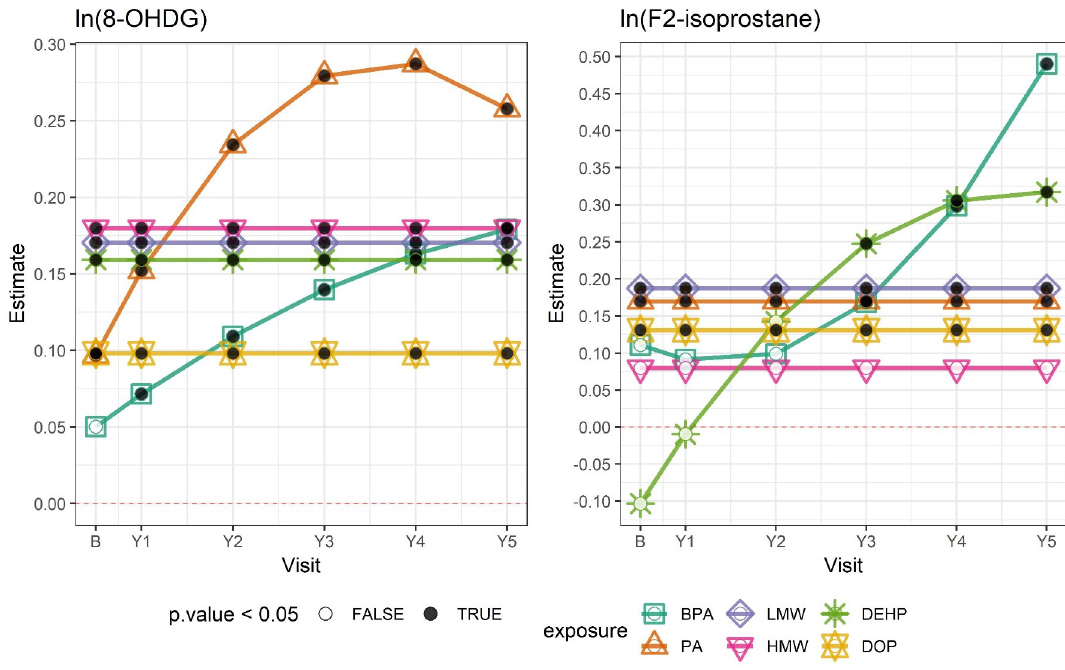
Fig 2. Associations between ln-transformed chemical exposures and ln-transformed oxidative stress biomarkers by study visit. Outcome estimates were derived from adjusted linear mixed-effects (LME) models and correspond to a 1–standard deviation change in each ln-transformed chemical exposure. Numerical estimates are shown in S4 Table. The horizontal dashed line indicates 0. Black dots indicate that the estimate had a p- value < 0.05; white dots indicate a p- value � 0.05. 8-OHDG: 8-hydroxy-2 0 -deoxyguanosine; B, baseline; BPA, bisphenol A; DEHP, di(2-ethylhexyl) phthalate; DOP, di-n-octyl phthalate; HMW, high molecular weight phthalates; LMW, low molecular weight phthalates; PA, phthalic acid; Y[number], year [number].